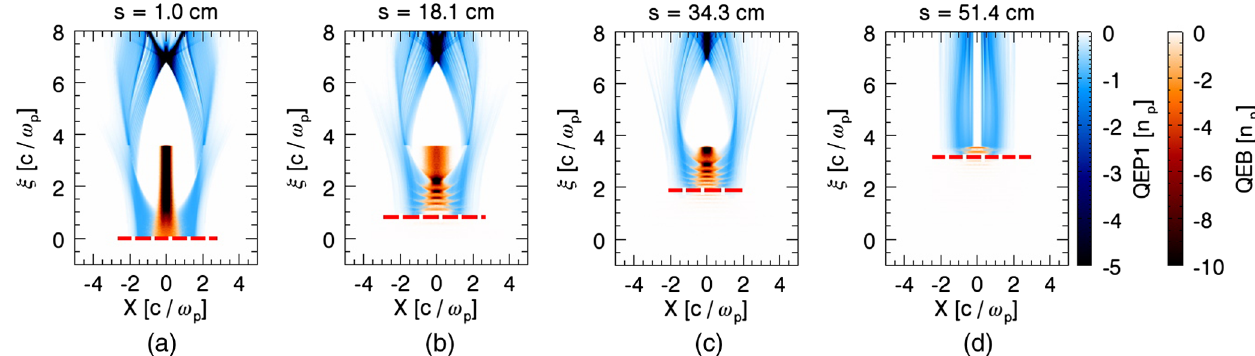
FIG. 3. Beam head erosion in the field-ionized lithium plasma. The plasma electron density has the blue color and the beam density is in brown. (cid:3) ¼ ct (cid:3) z is the distance in the speed of light frame and s ¼ z is the propagation distance in the lab frame. Dotted lines in (a)–(d) show the position of the ionization front.